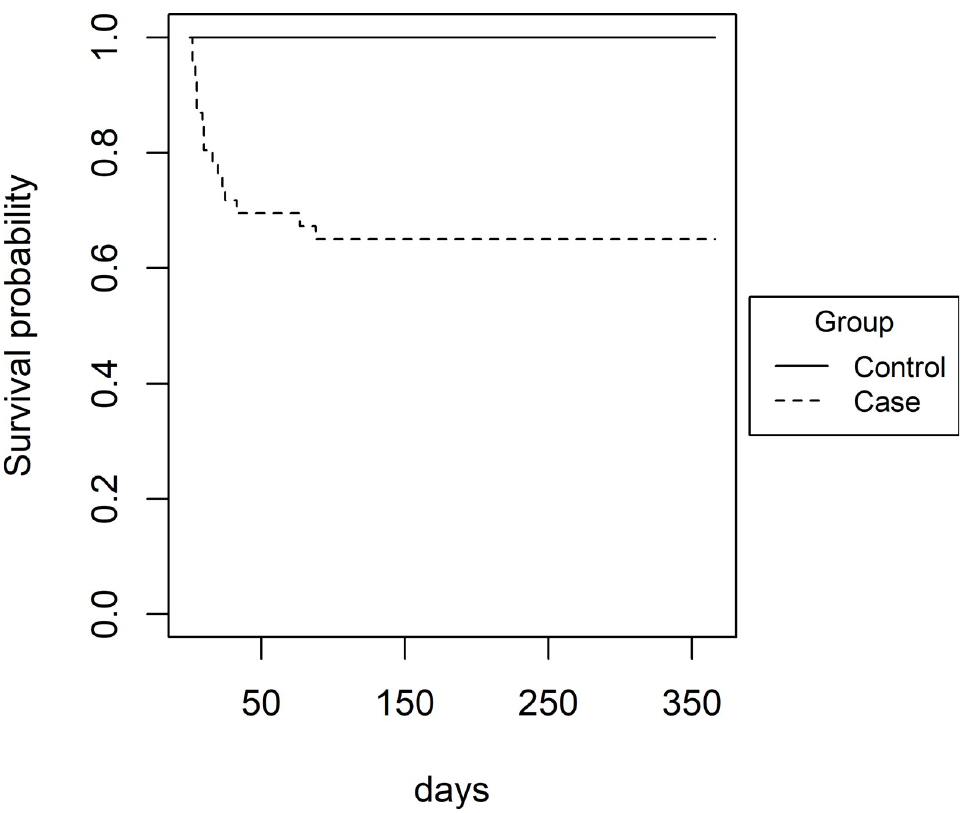
Fig 2. One-year survival curves for patients with and without a diagnosis of severe Strongyloides stercoralis infection after solid organ transplantation (cases and controls, respectively).